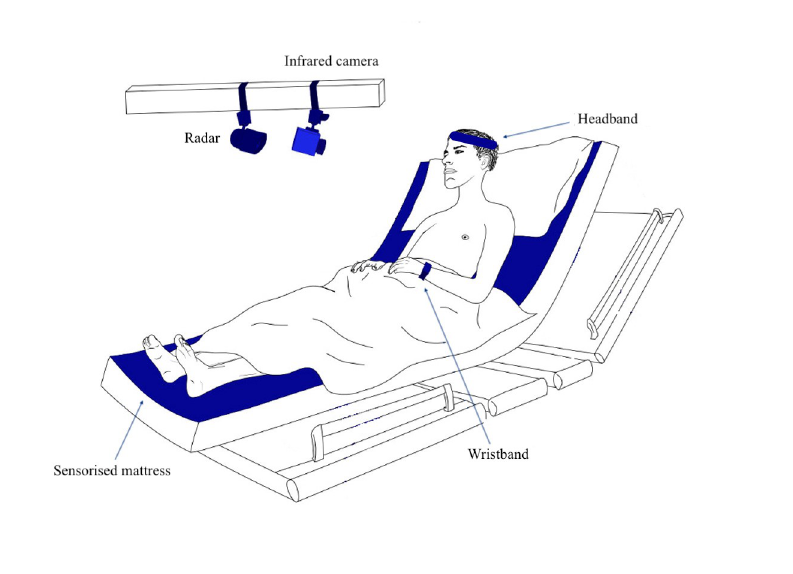
Figure 5. The unobtrusive multidimensional sensor network comprises contactless technologies, such as radar and infrared (“ambient” devices). The subject lies on a mattress with integrated pressure sensors, wearing a smart wristband and a headband with EEG electrodes